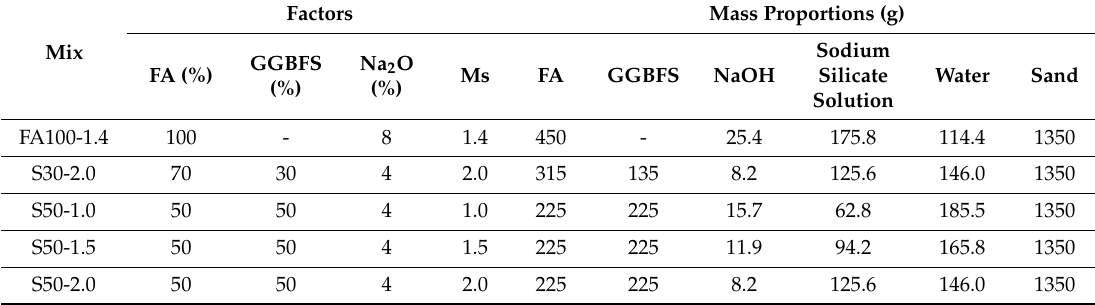
Table 2. Mixture proportions of tested mortars. Note that Ms indicates the SiO 2 / Na 2 O molar